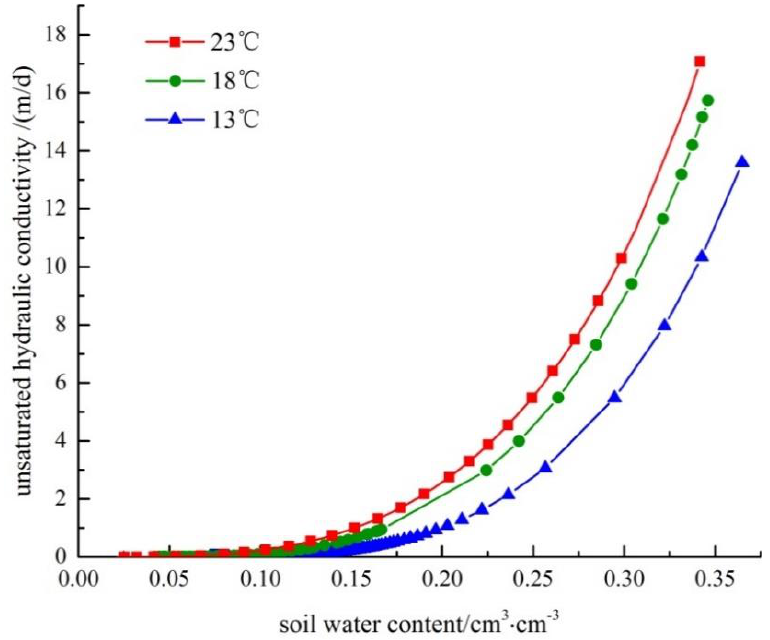
Figure 9. Predicted unsaturated soil hydraulic conductivity curves at different temperatures.